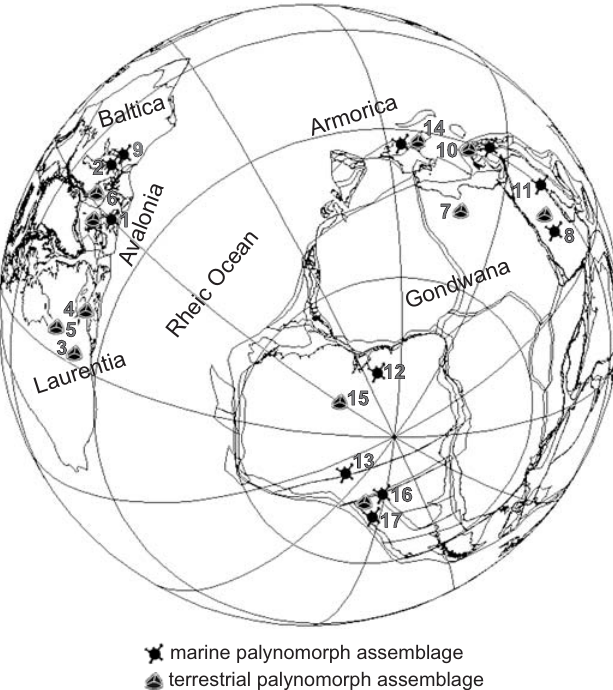
Fig. 4. Ludlow–P ř ídolí (424 My) phytoplankton and miospore assemblages plotted on a palaoegeographic reconstruction using BugPlate software (Torsvik 2009). 1, UK (Richardson and Lister 1969; Lister 1970; Richardson et al. 1981; Burgess and Richardson 1995; Wellman and Richardson 1996; Richards and Mullins 2003; Mullins 2001, 2004); 2, Gotland, Sweeden (Stricanne et al. 2004; Stricanne et al. 2006); 3, Allenport, USA (Beck and Strother 2008); 4, Nova Scotia, Canada (Beck and Strother 2001); 5, Ontario, Canada (McGregor and Camfield 1976); 6, Sweden (Mehlqvist et al. 2012; Mehlqvist et al. 2014); 7, Libya (Richardson and Ioannides 1973; Rubinstein and Steemans 2002; Le Hérissé 2002); 8, Saudia Arabia (Le Hérissé et al. 1995; Wellman et al. 2000; Breuer et al. 2017); 9, Poland (Por ę bska et al. 2004); 10, Turkey (Steemans et al. 1996; Lakova and Göncüo ğ lu 2005); 11, Iraq (Al-Almeri 1984; 2010); 12, Maranhão Basin, Brazil (Brito 1967); 13, Bolivia (Cramer et al. 1974; Kimyai 1983; Racheboeuf et al. 2012); 14, Spain and West France (Rodríguez González 1978; 1983; Steemans 1989; Cramer 1964a; Richardson et al. 2001); 15, Amazon Basin, Brazil (Cardoso 2005; Steemans et al. 2008); 16, Santiago del Estero, Argentina (Pöthe de Baldis 1974a); 17, Precordillera Argentina (Rubinstein 1992a, b, 1995; García Muro et al. 2014b; this contribution). References discussed in the papers are also included.